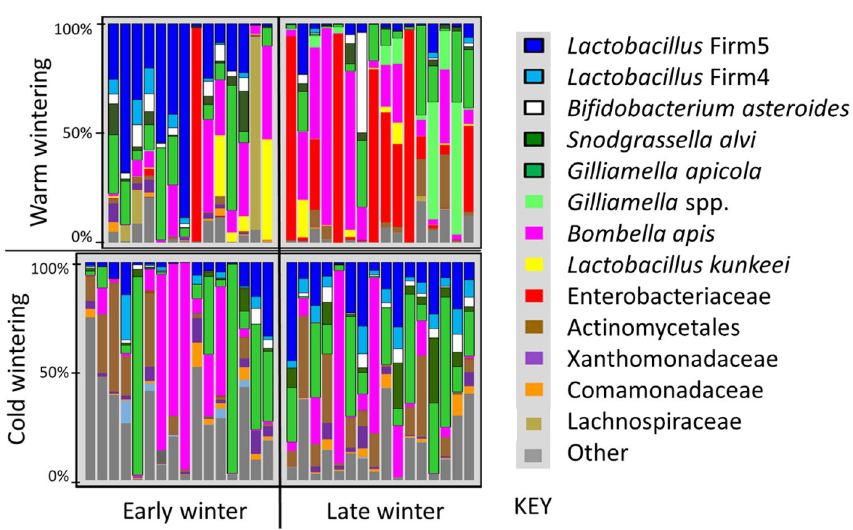
Figure 5. Relative abundance of midgut microbiotas (KEY = OTUs) in early and late winter of worker bees from colonies placed in an indoor climate-controlled facility: “Cold wintering”, or outdoors in Southern Arizona, USA: “Warm wintering”, on the y-axis. Each vertical bar is the midgut microbiota of a single bee from a different colony ( n = 14 or 16). Outlined in bold within the key, the core five hindgut bacteria declined significantly in the warm outdoor environment, but increased significantly in the cold indoor environment. Significantly larger midgut microbiotas are associated with Enterobacteriaceae (RED) and Gilliamella spp. (GFP green). See Supplementary Table S1 and results for more